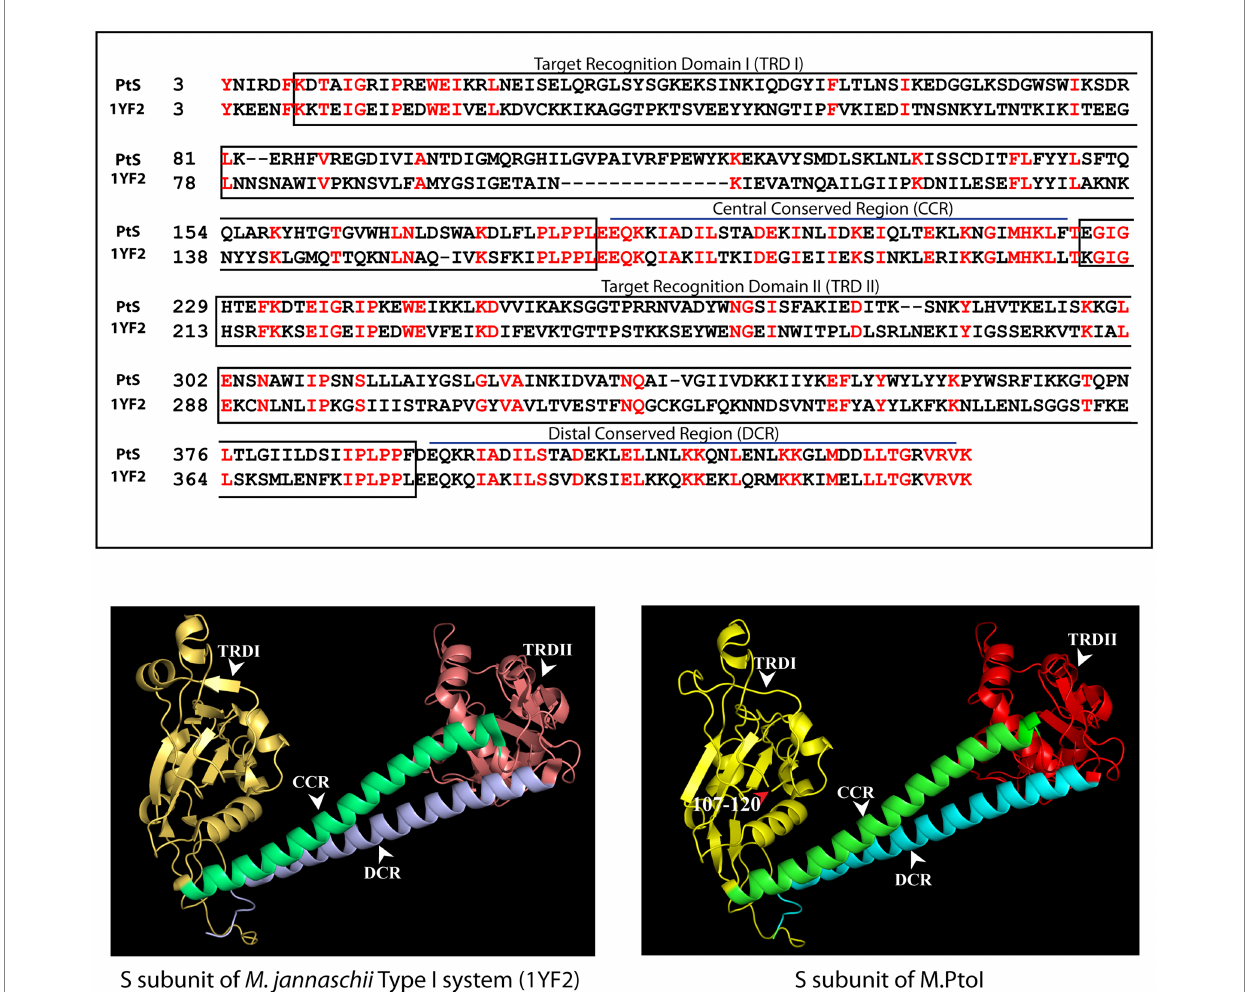
FIGURE 4 Structural analysis of S subunit of M.PtoI: Upper panel: Alignment of sequence of S subunit of M.PtoI with S subunit of Methanocaldococcus jannaschii Type I R-M system, using Phyre2. The boxes demarcate the positions of the domains conserved between the two subunits. Lower left panel: Ribbon representation derived from X-ray crystallography structure (2.4 Å) of M. jannaschii Type I RM system’s S subunit [pdb ID: 1YF2, reported by Kim et al. (2005)]. Lower right panel: Ribbon representation of 3D model of S subunit of M.PtoI, modelled against the 1YF2 S subunit structure using Phyre2. Arabic numerals depict amino acid residues that were excluded from the models. TRDI and TRDII: Target Recognition Domain I and Target Recognition Domain II representing the globular domains of the N-terminal and C-terminal TRDs, respectively. CCR: Central Conserved Region, DCR: Distal Conserved